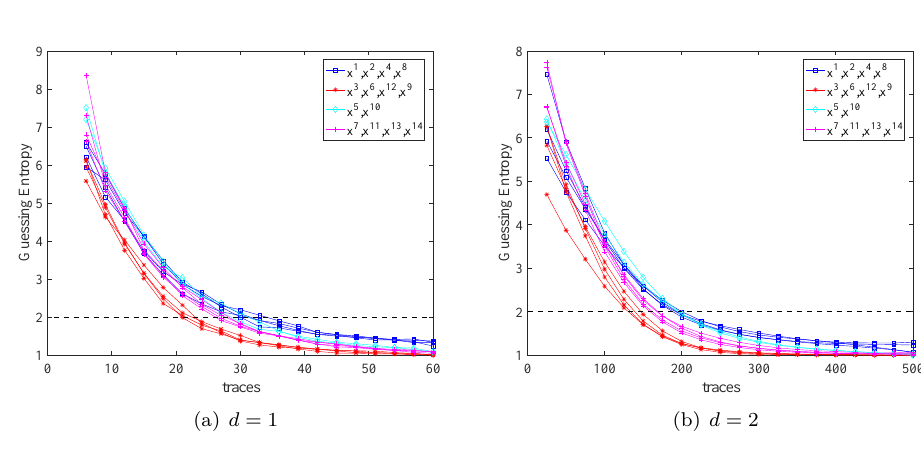
Figure 2: The results of GE for n = 4 and σ = 0 .